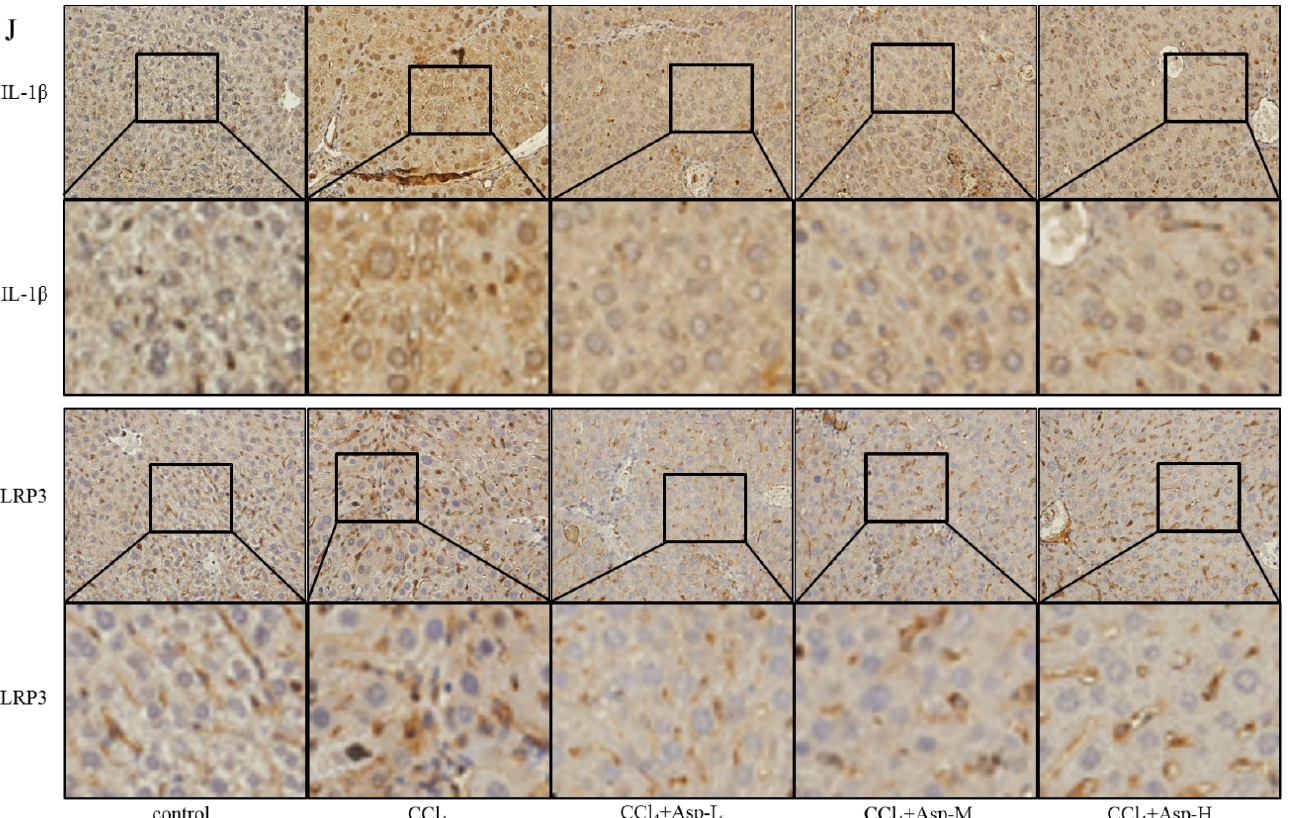
Figure 5. Treatment with Asp blocked hepatic NF- κB/NLRP3 expression in vitro and in vivo . ( A ) LX-2 cells were stimulated with lipopolysaccharide (LPS) (1 μg/mL or 2 μg/mL) for 6 h, and then the cells were collected to assess α -SMA, COL Ⅲ , FN, NLRP3, and IL- 1β expression levels by Western blot. ( B ) After 6 h of the addition of 1 μg/mL LPS, the medium was replaced with new medium in the presence or absence of Asp (15 mM), and the cells were incubated for an additional 24 h before harvesting. Protein levels were analyzed by Western blot analysis. ( C – E ) LX-2 cells were treated with Aspartate in different concentrations or at different times. ( C , D ) Real-time PCR was assessed to investigate the mRNA level of NLRP3, p-NF- κB, and IL- 1β. ( E , F ) Western blot was assessed to investigate the protein level of NLRP3, p-NF- κB, and IL- 1β (n = 3). ( G – J ) The expression of the inflammation markers NLRP3, p-NF- κB, IL - 1β was detected by real-time PCR ( G ), Western blot ( H ), and immunohistochemistry ( J ), n = 5. ANOVA was used for statistical analysis. The results shown are mean ± standard error of the mean. * p < 0.05, ** p < 0.01.